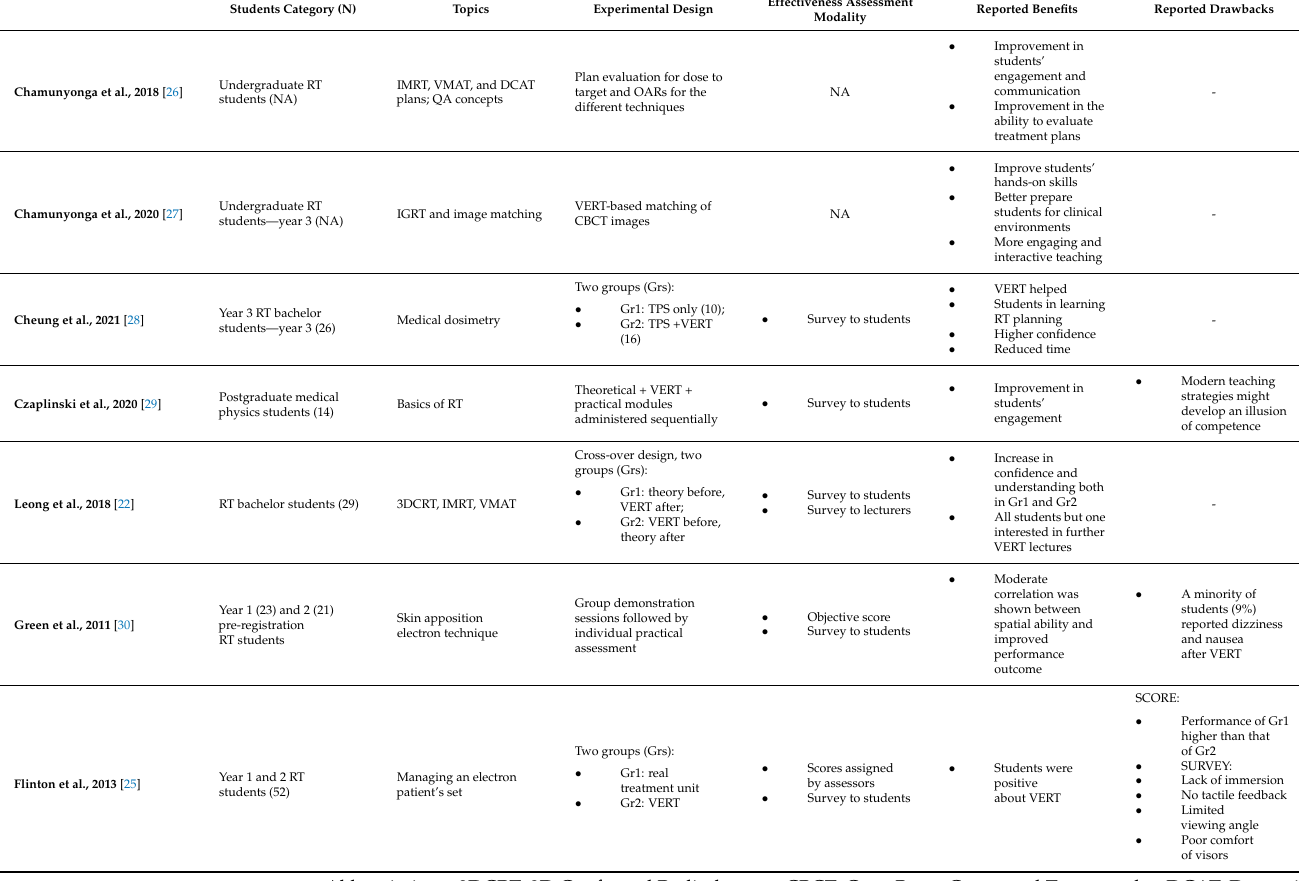
Table 1. Examples from literature of use of Virtual Environment Radiotherapy Training (VERT) for students’